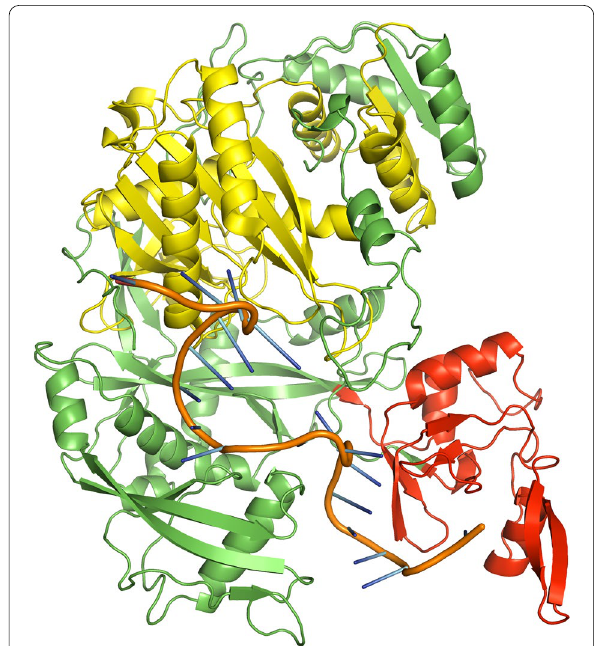
Fig. 5 A docked complex of AGO2 and N11.2. RNA, PAZ, PIWI, and the remaining regions are represented in orange, red, yellow, and green colors, respectively